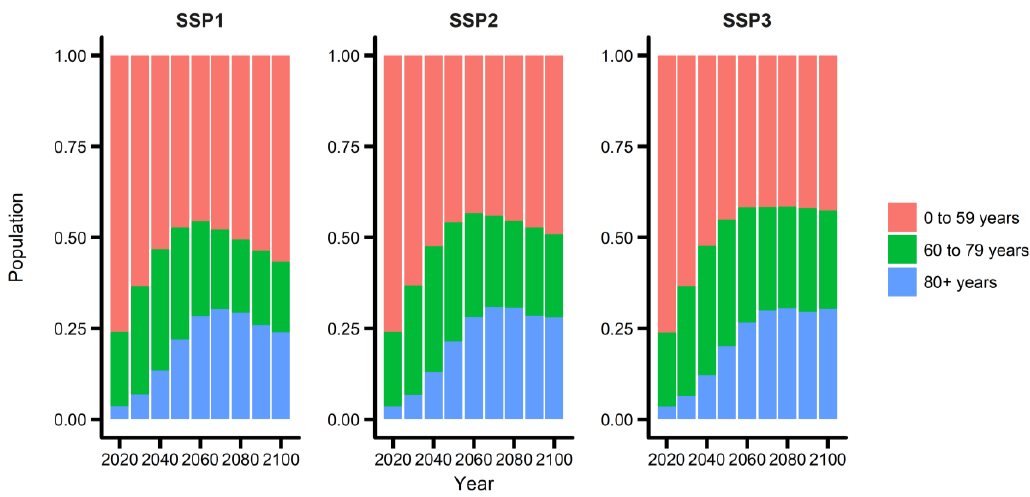
Figure 2. Population composition changes under the SSP 1, 2 and, 3 scenarios in the seven cities. SSP, Shared Socioeconomic Pathway.